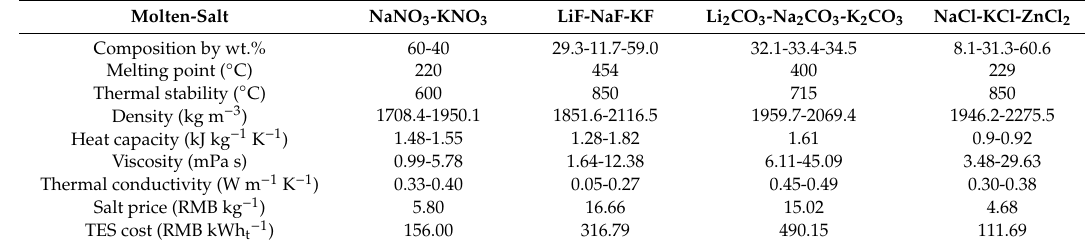
Table 6. Thermal properties and thermal energy storage (TES) costs of selected molten-salts. Molten-Salt NaNO 3 -KNO 3 LiF-NaF-KF Li 2 CO 3 -Na 2 CO 3 -K 2 CO 3 NaCl-KCl-ZnCl 2 Composition by wt.% 60-40